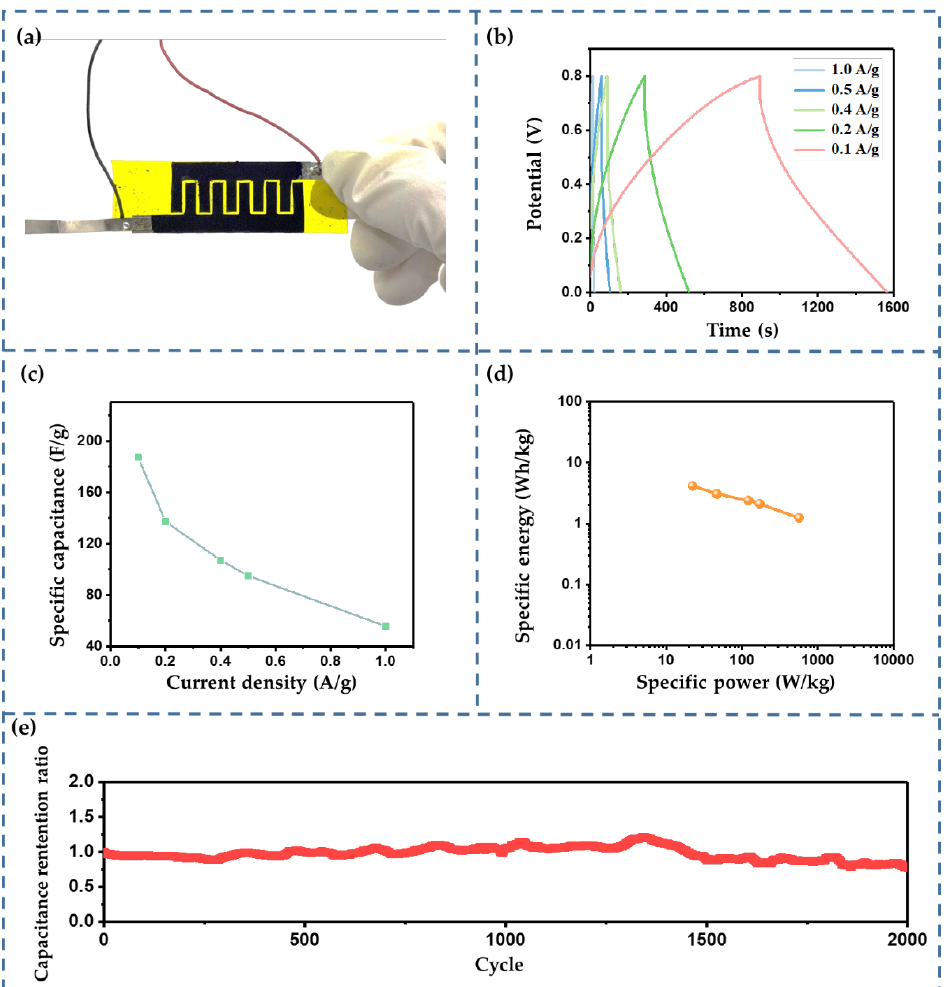
Figure 12. ( a ) The fabricated IDTSC sensor. ( b ) GCD curves of IDTSC at different current levels. ( c ) The specific capacitance vs. the current density. ( d ) Ragone plot of the IDTSC. ( e ) Cyclic durability characteristics of IDTSC.